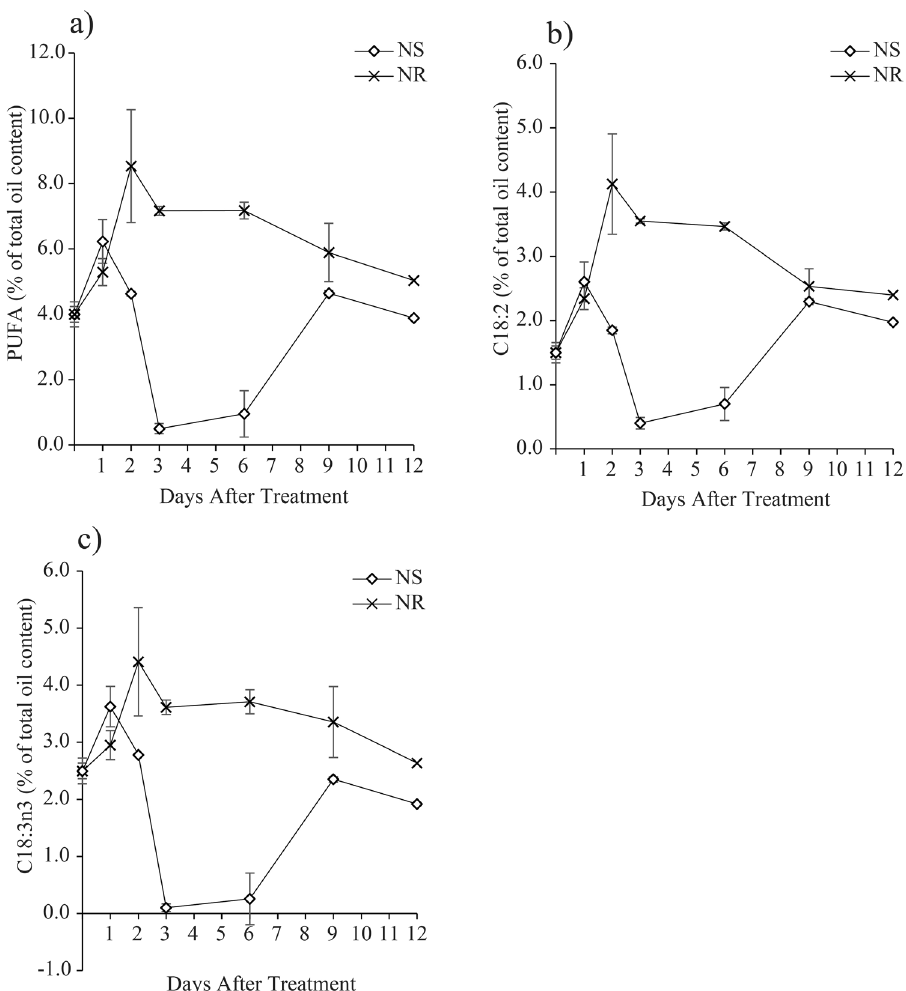
Figure 5. Effect of nitrate availability on polyunsaturated fatty acids (PUFA) composition of M. gracile SE-MC4 cultivation during early (day 1, 2 and 3), mid (day 6 and 9) and late (day 12) treatment periods. ( a ) Overall